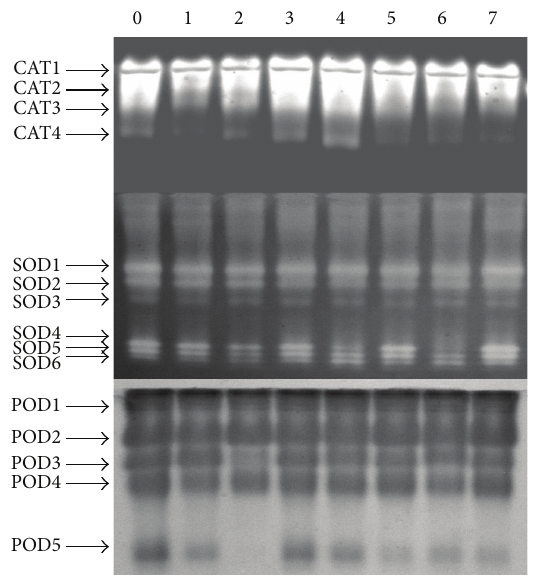
Figure 3: Identification of different isoenzymes (A-CAT, B-SOD, and C-POD) in L. sinense seedlings under NaCl stress. Each lane contains 45 𝜇 g protein. Arrows indicate different CAT, SOD, and POD